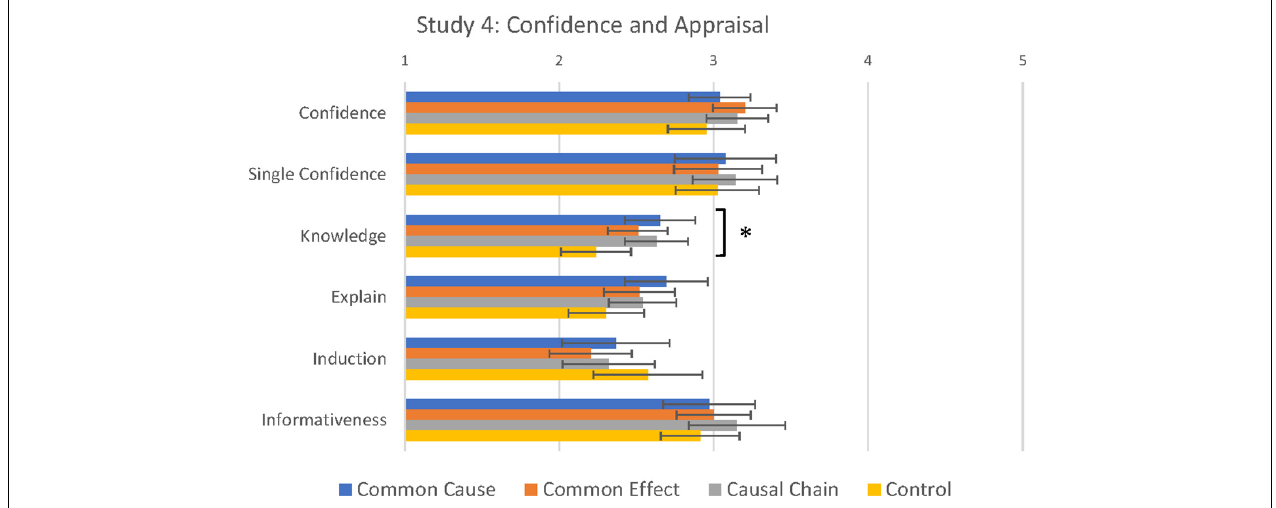
FIGURE 6 | Confidence and concept appraisal as a function of causal condition in Study 4. *Main effect of condition significant at < 0.05, see